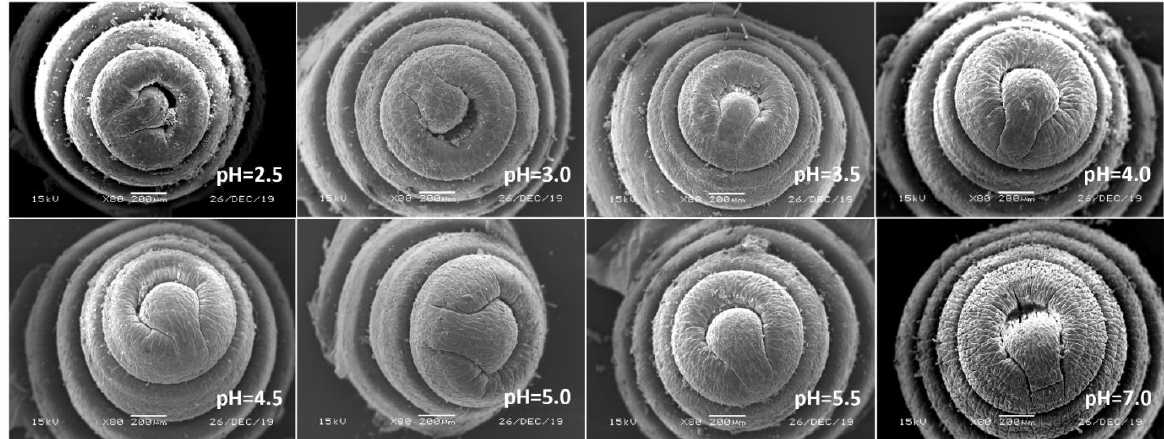
Figure 5. Prostomium of adult Eisenia fetida in soil under acid rain with eight pH levels for 15 days ( n = 10). Treatments: pH 7.0: control, pH 2.0–5.5: acid rain with different pH levels.